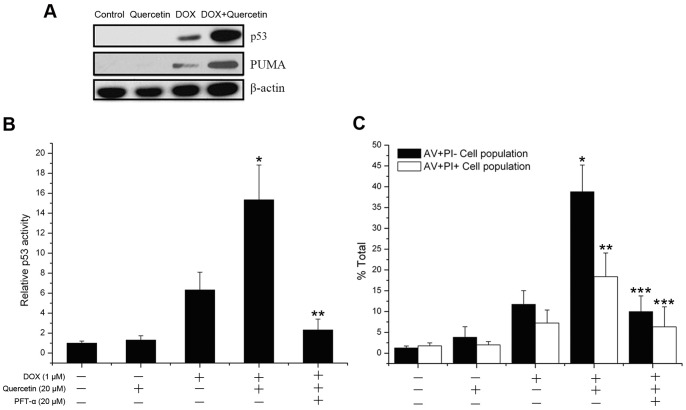
Quercetin potentiates DOX-induced apoptosis of SMMC7721 cells in a p53-dependent manner.(A) p53 and PUMA expressions were assessed by western blot in SMMC7721 cells treated with DOX (1 µM) and/or quercetin (20 µM) for 24 h. β-actin was used as an internal control. (B) The luciferase assay of DOX- and quercetin-induced p53 activation. SMMC7721 cells were pretreated for 1 h with 2 µM of pifithrin-α, and then treated with DOX (1 µM) or quercetin (20 µM) for 12 h. p53 activity was determined by luciferase activity assay. Data are presented as mean ± S.D. of three independent experiments. *P<0.01 vs. DOX-treated cells. **P<0.001 vs. DOX + quercetin-treated cells. (C) SMMC7721 cells were pretreated with 2 µM of pfithrin-α for 1 h, and then treated with DOX (1 µM) and/or quercetin (20 µM) for 24 h. Apoptosis rates were assayed by Annexin V/PI staining. Data are presented as mean ± S.D. of three independent experiments. *P<0.001 vs. DOX-treated cells. **P<0.01 vs. DOX-treated cells. ***P<0.001 vs. DOX + quercetin-treated cells.